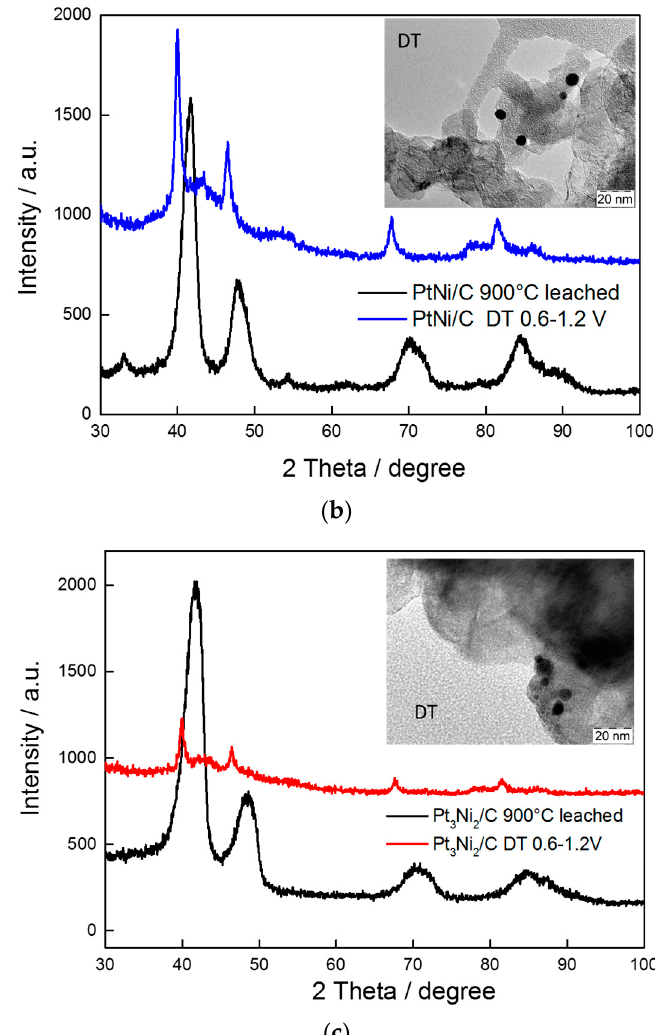
Figure 9. XRD patterns of carbon supported ( a ) Pt/C; ( b ) PtNi1C; ( c ) Pt 3 Ni 2 /C catalysts before and after the ADT. The inset shows the TEM image of the catalyst after the ADT.